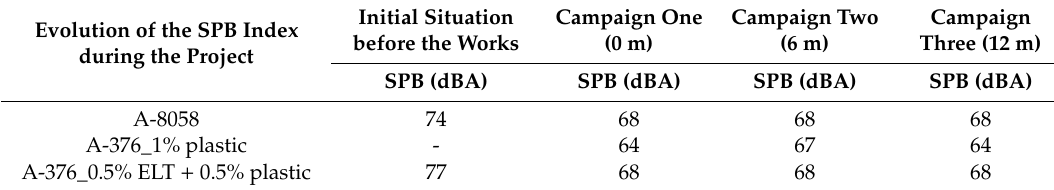
Table 6. SPB values before and after paving the mixtures.